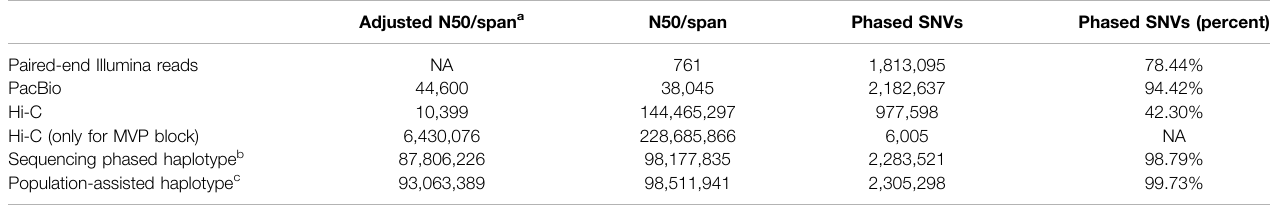
TABLE 1 | Haplotype block statistics with diverse sequencing protocols for r220.